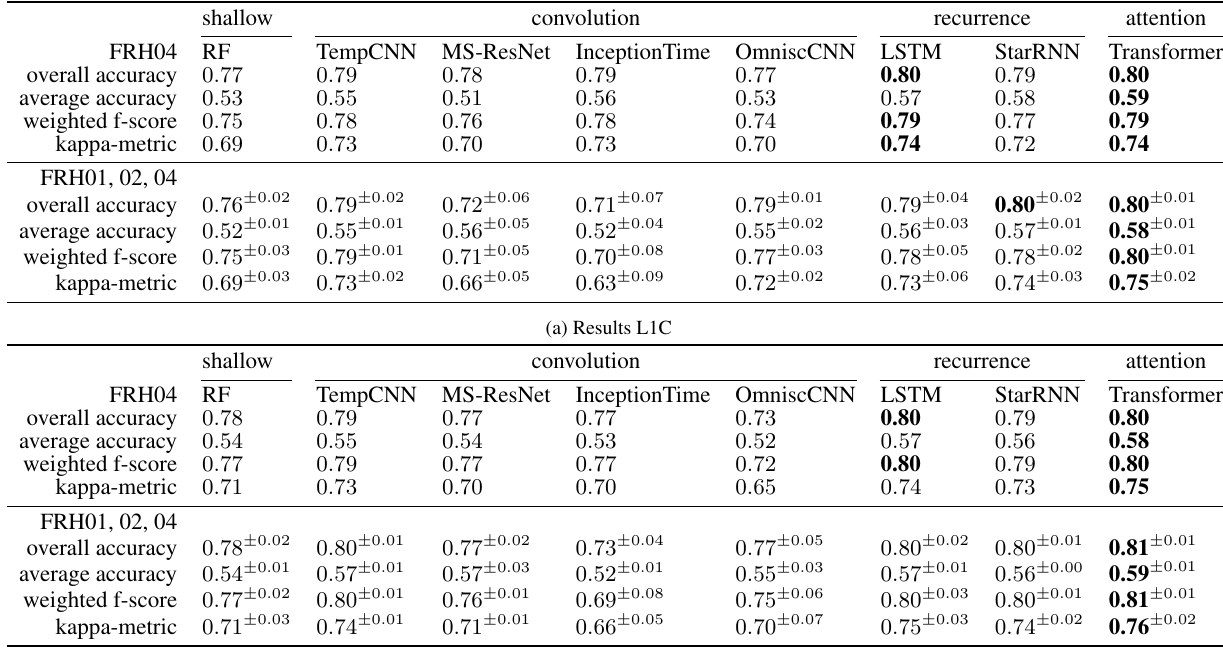
Table 2. Accuracy metrics of all models benchmarked on the Breizhcrops dataset, considering L1C (a) and L2A (b) data. For each table, the top part displays the performance obtained when testing on the FRH04 region while training on the three remaining areas, whereas the bottom part displays average performance (plus one standard deviation) when models were tested on FRH01, FRH02 and FRH04 regions. Bold values show the highest